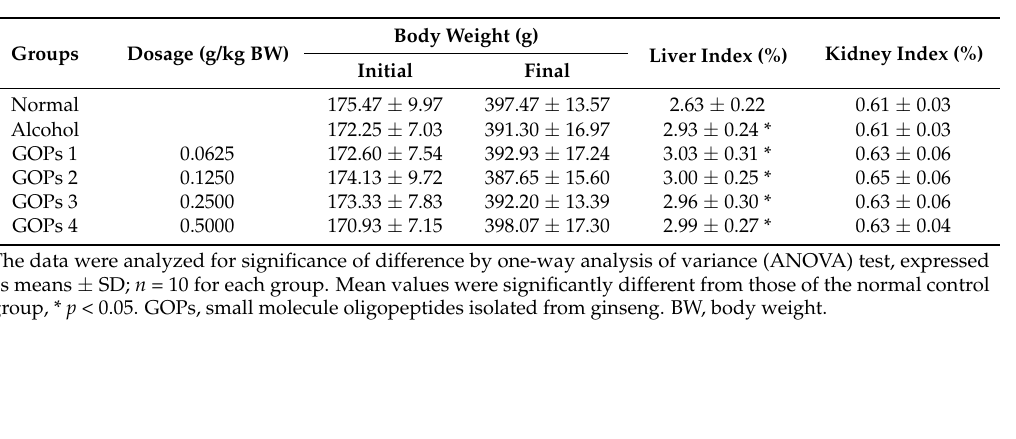
Table 3. Effects of GOPs on body weight and organ index in